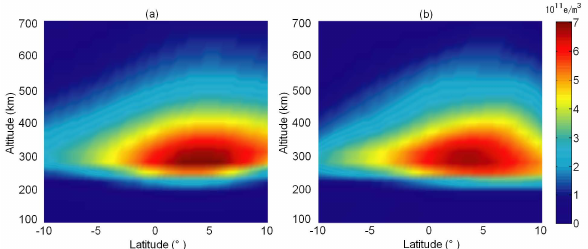
Fig. 2. Ionospheric electron density distribution at longitude 100 ◦ E. (a) Original electron density distribution using the NeQuick model. (b) Reconstructed electron density distribution. hmF2, and N ion